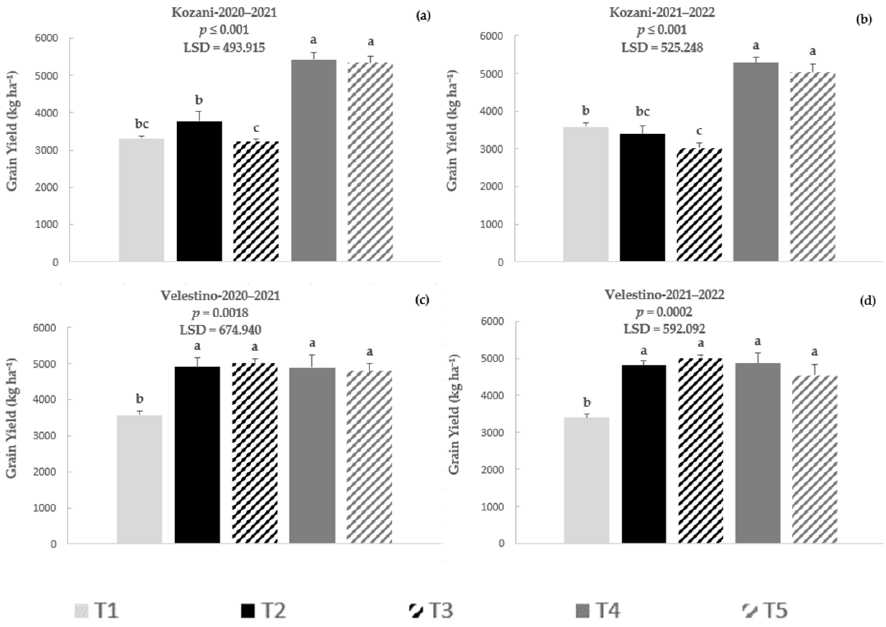
Figure 5. Grain yield (kg ha − 1 ) in ( a ) Kozani-2020–2021, ( b ) Kozani-2021–2022, ( c ) Velestino-2020– 2021, and ( d ) Velestino-2021–2022. Treatment DF: 4; Error DF = 15; Total DF = 19; DF: Degrees of Freedom. At each site-year, different lowercase letters indicate significant differences between treatment means according to Fisher’s LSD test ( a = 0.05). Vertical bars indicate standard errors. Significant relationships were observed between crop NDVI and grain yield in Kozani ( p ≤ 0.05), but not in Velestino ( p ≥ 0.05). These results were the same in both experimental years (Figure